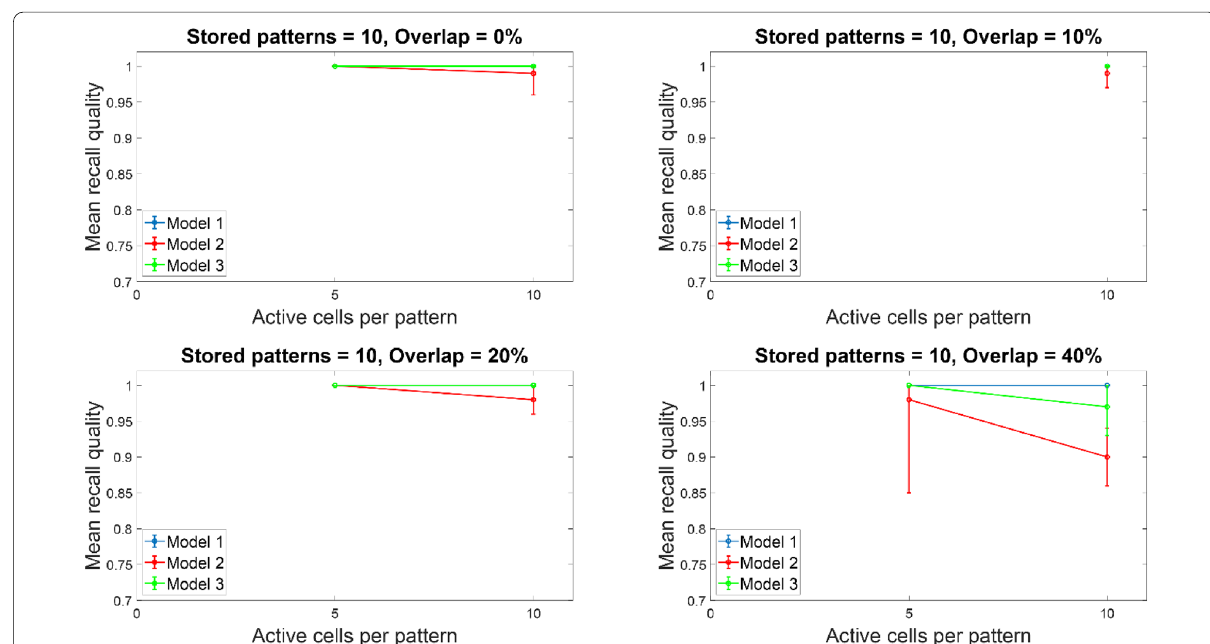
Fig. 13 Mean recall quality of ‘model 1’, ‘model 2’, and ‘model 3’ as a function of active cells per pattern (5, 10, 20) when 10 patterns were stored with various percentages of pattern overlap. Each model was a network of 300 PCs, one BSC, and one OLM cell